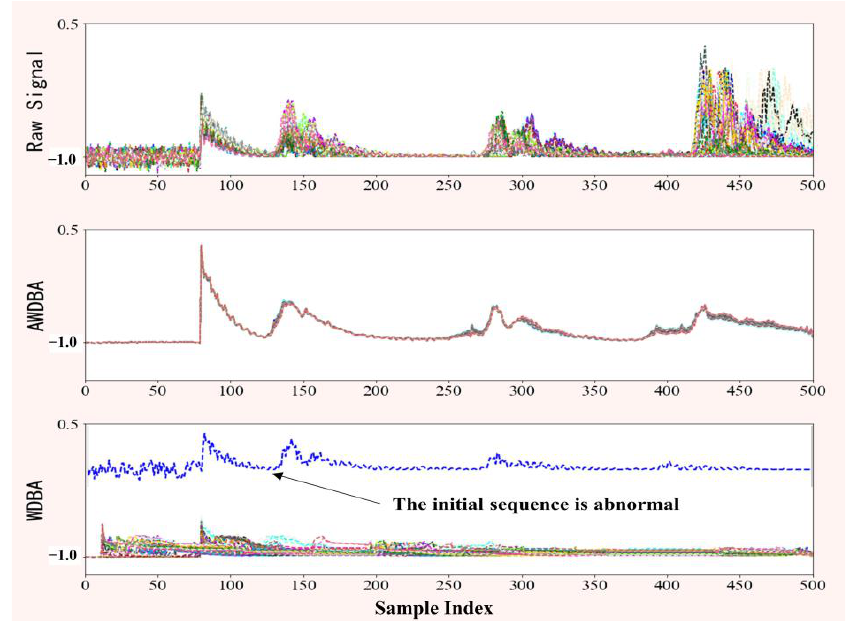
Figure 4. Results of AWDBA and WDBA for data augmentation.